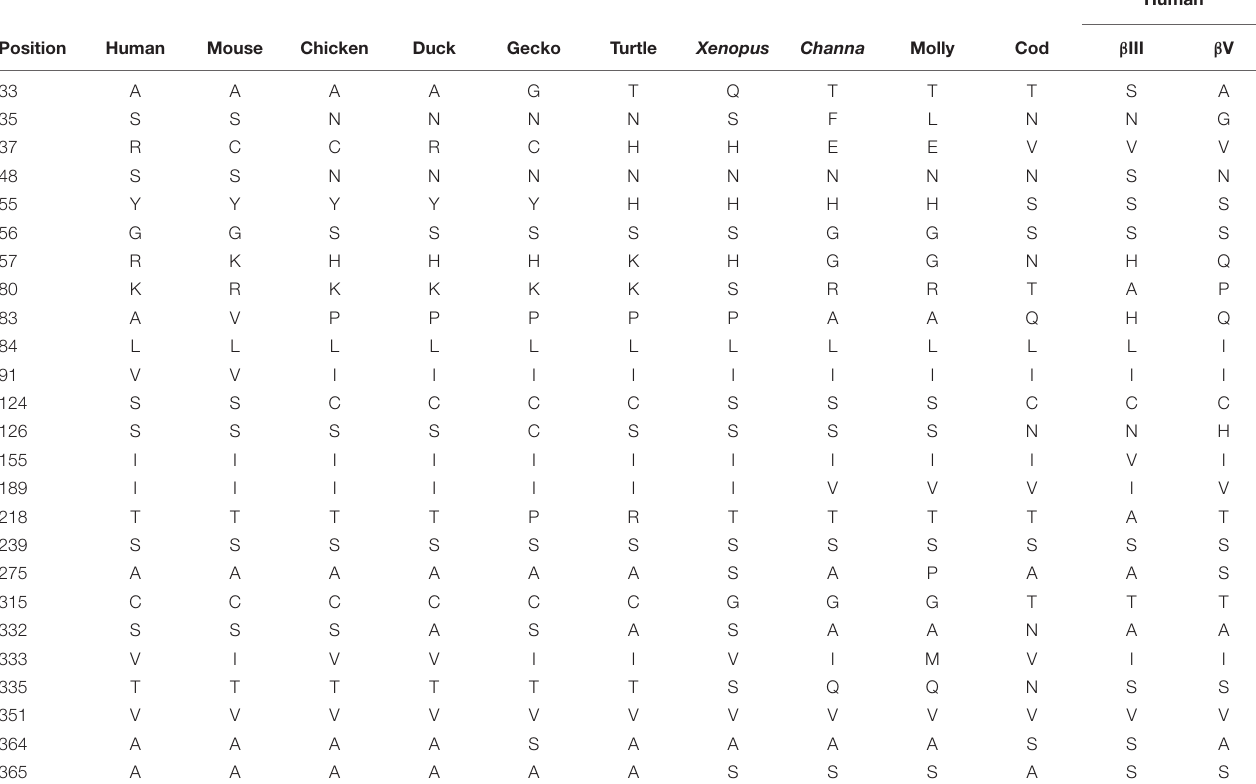
TABLE 2 | Key Positions in Vertebrate β VI-Tubulin Isotypes a